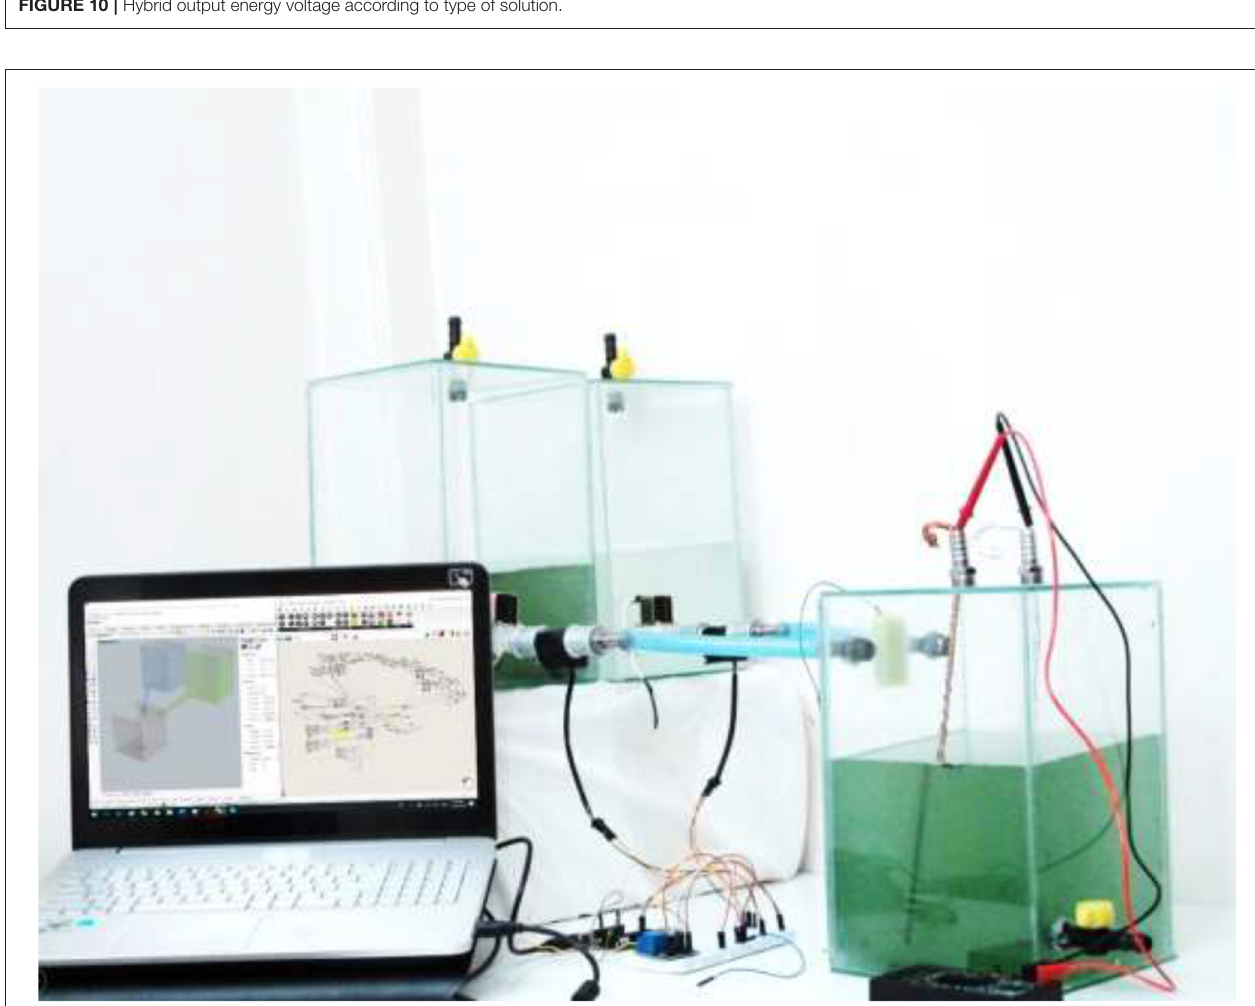
FIGURE 11 | Real-time